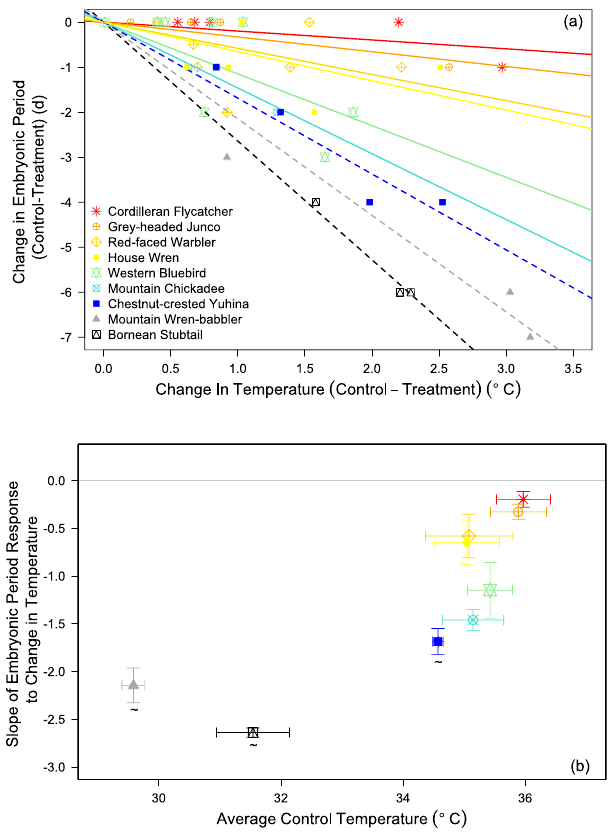
Figure 2. ( a ) Correlation between measured differences in egg temperature, and incubation period differences between treatment and control among 42 paired nests belonging to nine species at two latitudes. Each point represents a nest pair and each symbol and color a different species. Individual regression lines provide the intraspecific response of embryonic period to experimental heating and warmer colors are associated to warmer natural incubation temperature. Dashed lines denote tropical species. Names in figure legend are reported in order of ascending slope. ( b ) Correlation between average ( ± 1 SE) differences in control incubation temperature and change of embryonic period with treatment temperature (slope ± 1 SE) for nine songbird species at two latitudes. Tropical species are denoted as ~. The gray horizontal line intercepting zero represents the physiological threshold for development where further temperature increases produces no changes in embryonic